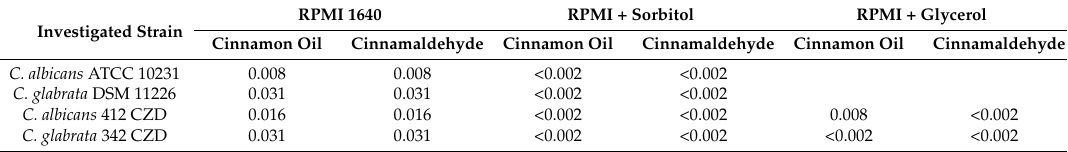
Table 6. MIC values for cinnamon oil and cinnamaldehyde in the presence and absence of sorbitol/glycerol. Investigated Strain